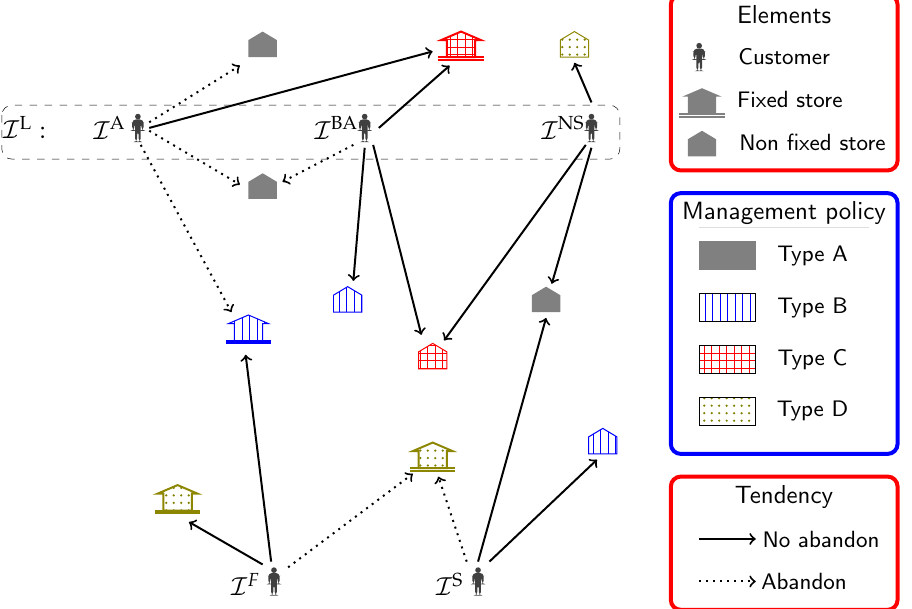
Figure 1. Classification of the customers.